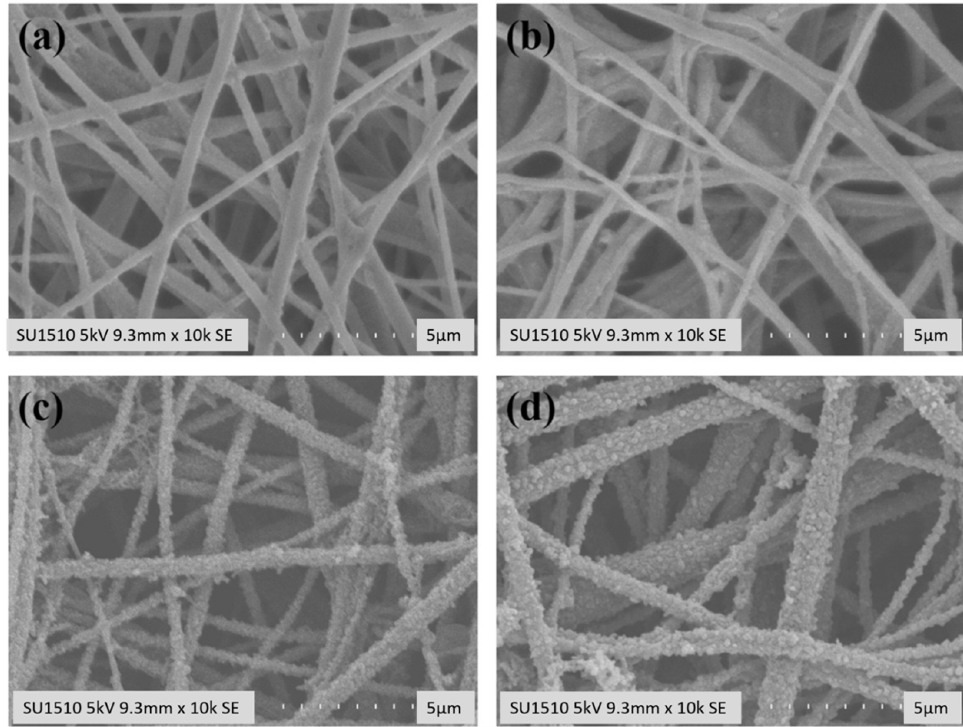
Figure 11. SEM images of CNF ( a ), CNF/TiO 2 ( b ), CNF/PANI ( c ) and CNF/TiO 2 /PANI composite ( d ). Reproduced from ref. [117].